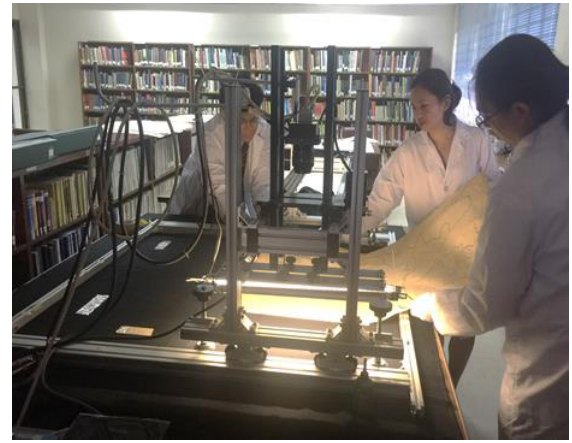
Figure 1. Map digitization using the NIJI-S